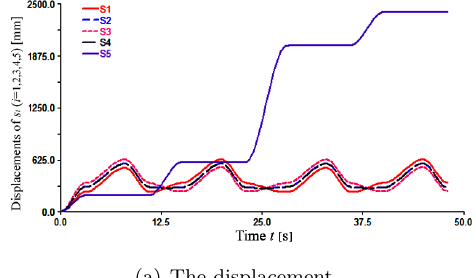
Figure 11: The kinematic variations of the drilling process of the hybrid machine tool